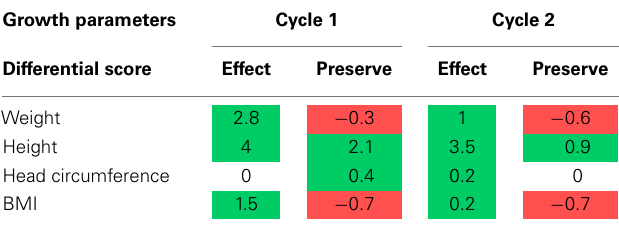
Table 4 | Differential scores of growth parameters during cycles